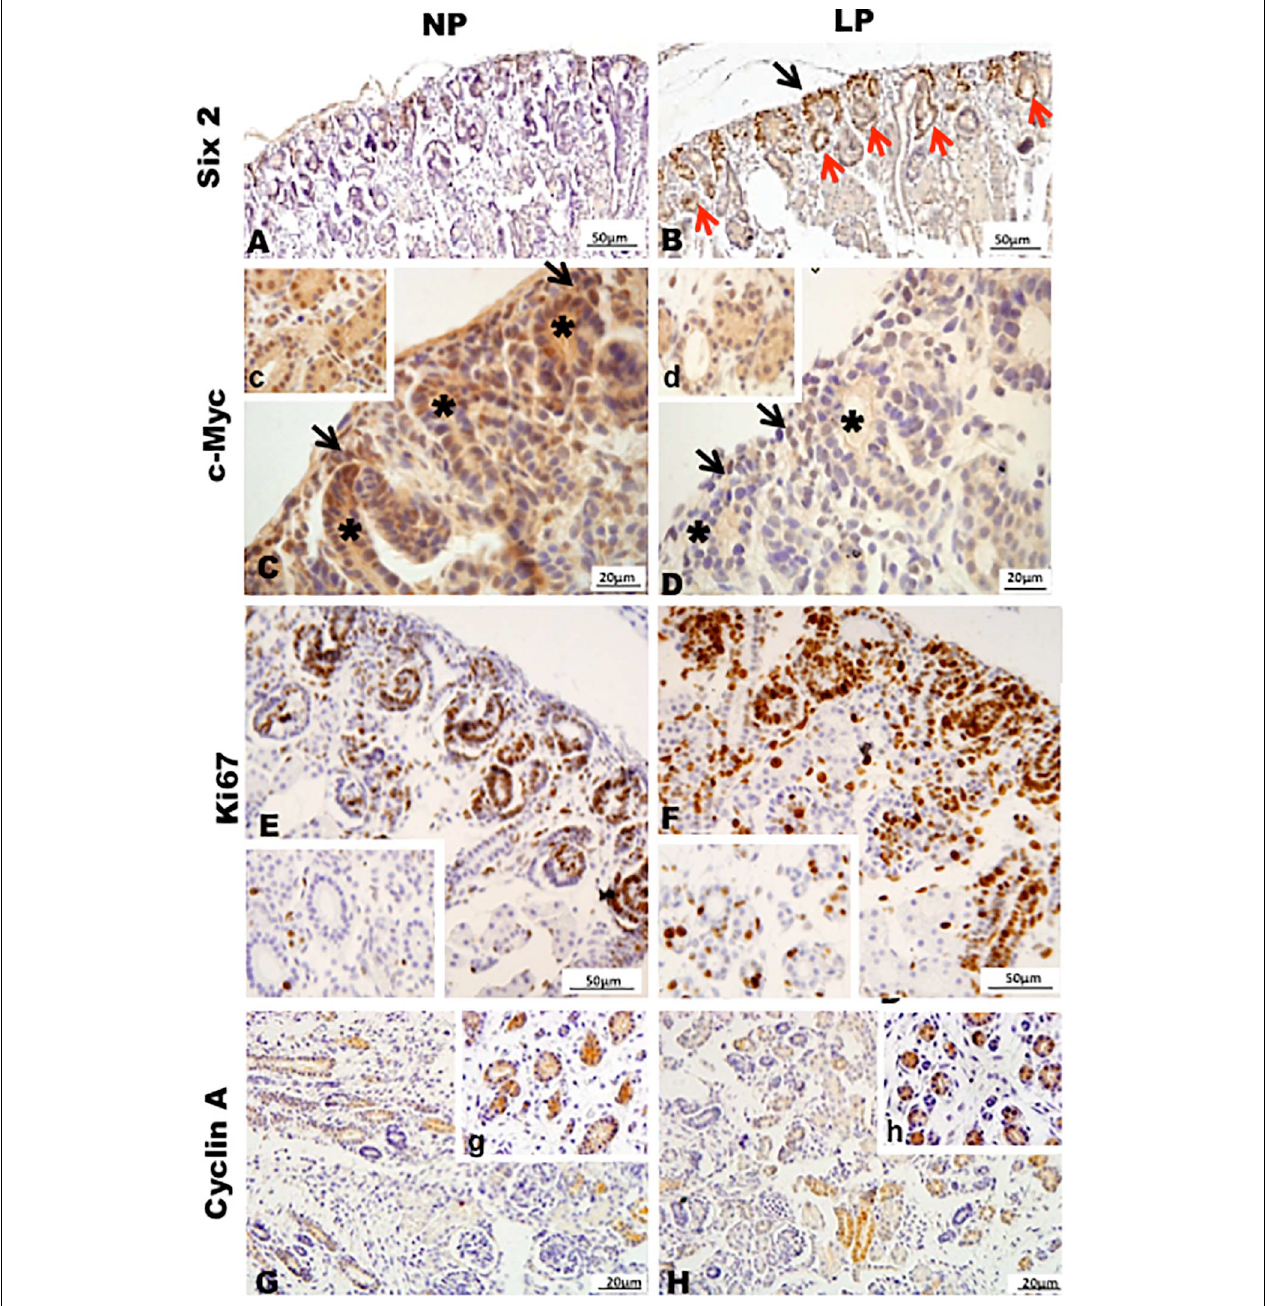
FIGURE 5 | Immunoperoxidase in kidneys of 21GD rats for (A,B) Six 2, (C,D) c-Myc, (E,F) Ki67, and (G,H) cyclin A for the NP (A,C,E,G) and LP (B,D,F,H) groups. CM (black arrow); UB (*) renal structures in differentiation (red arrow). The inserts represent a medullar area.